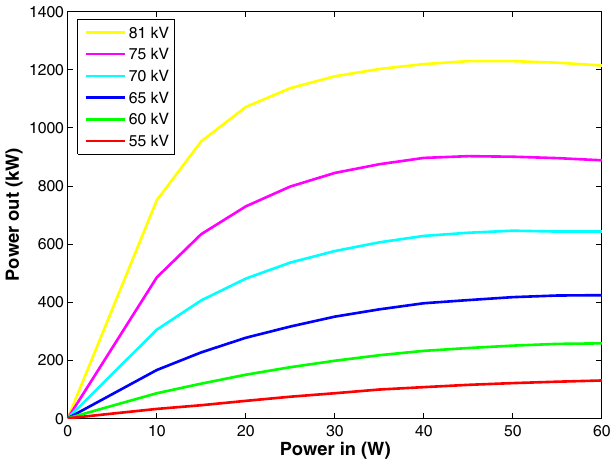
FIG. 2. (Color) Power curves for SLAC #5 klystron. For a desired output power, the operation point is defined by the high voltage power supply level and the input power.